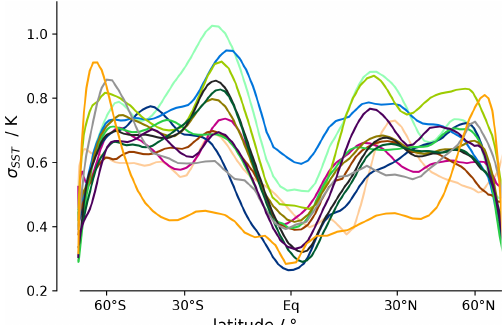
Figure 2. Zonal mean of the temporal standard deviation of monthly mean SST in the AquaControl simulations. The models are color-coded as in Fig.